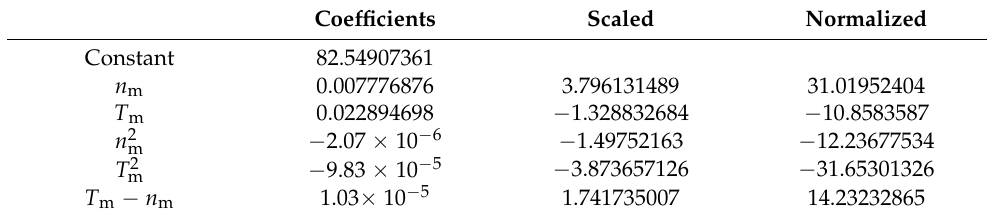
Table 2. Table of charging efficiency coefficients.